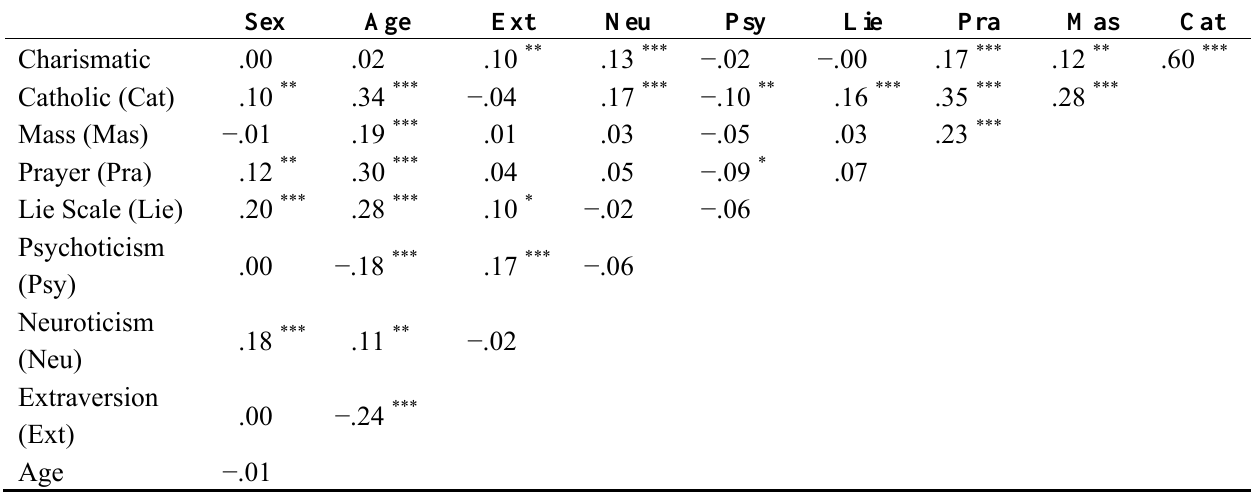
Table 3. Correlation matrix.